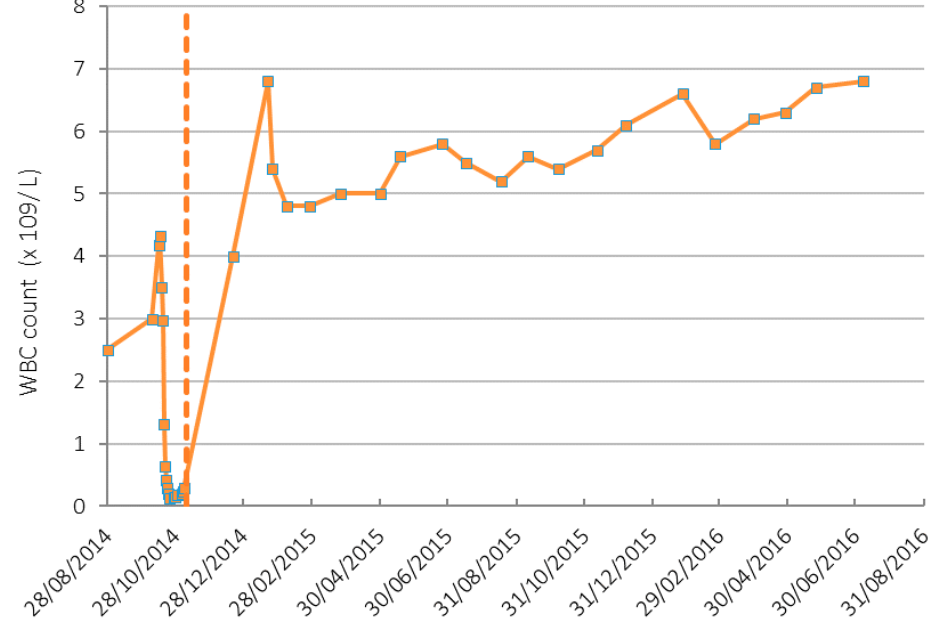
Figure 2. White blood cell (WBC) count in patient before and after IV vitamin C treatment. Dashed line indicates the IV vitamin C commenced date. Normal range of WBC count is 4.5–11 (×10 9 /L).